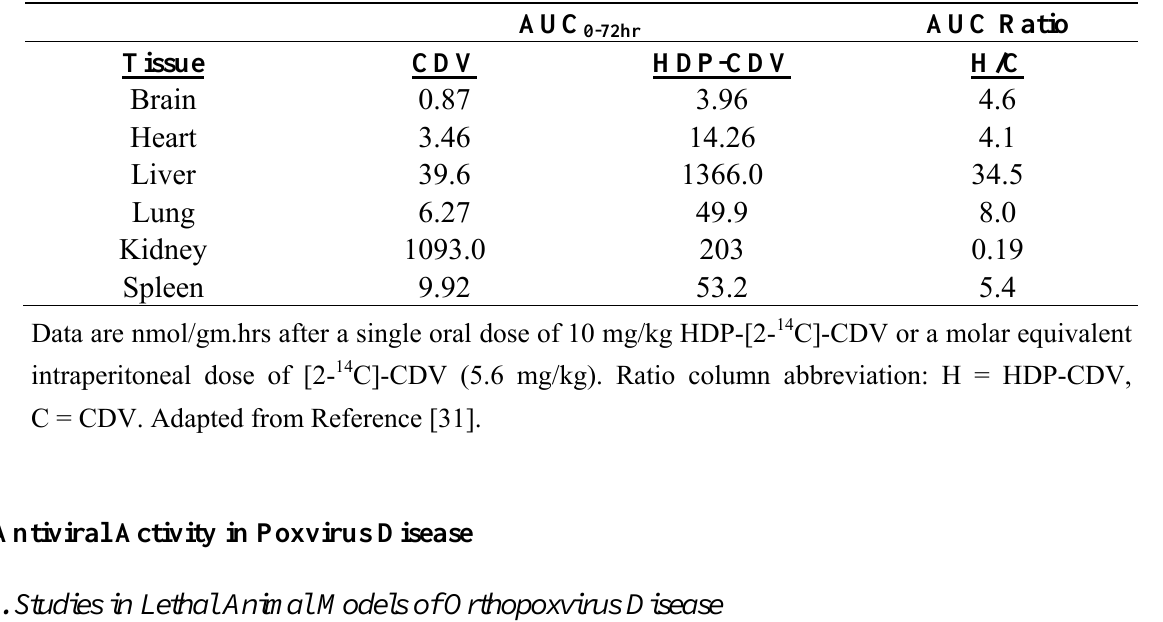
Table 2. Comparison of areas under curve with oral HDP-[2- 14 C]-CDV and intraperitoneal [2- 14 C]-CDV in mouse